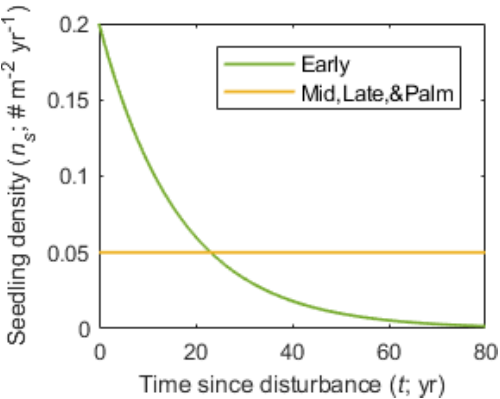
Figure 3. The seedling density from seed rain for each PFT as a function of time since